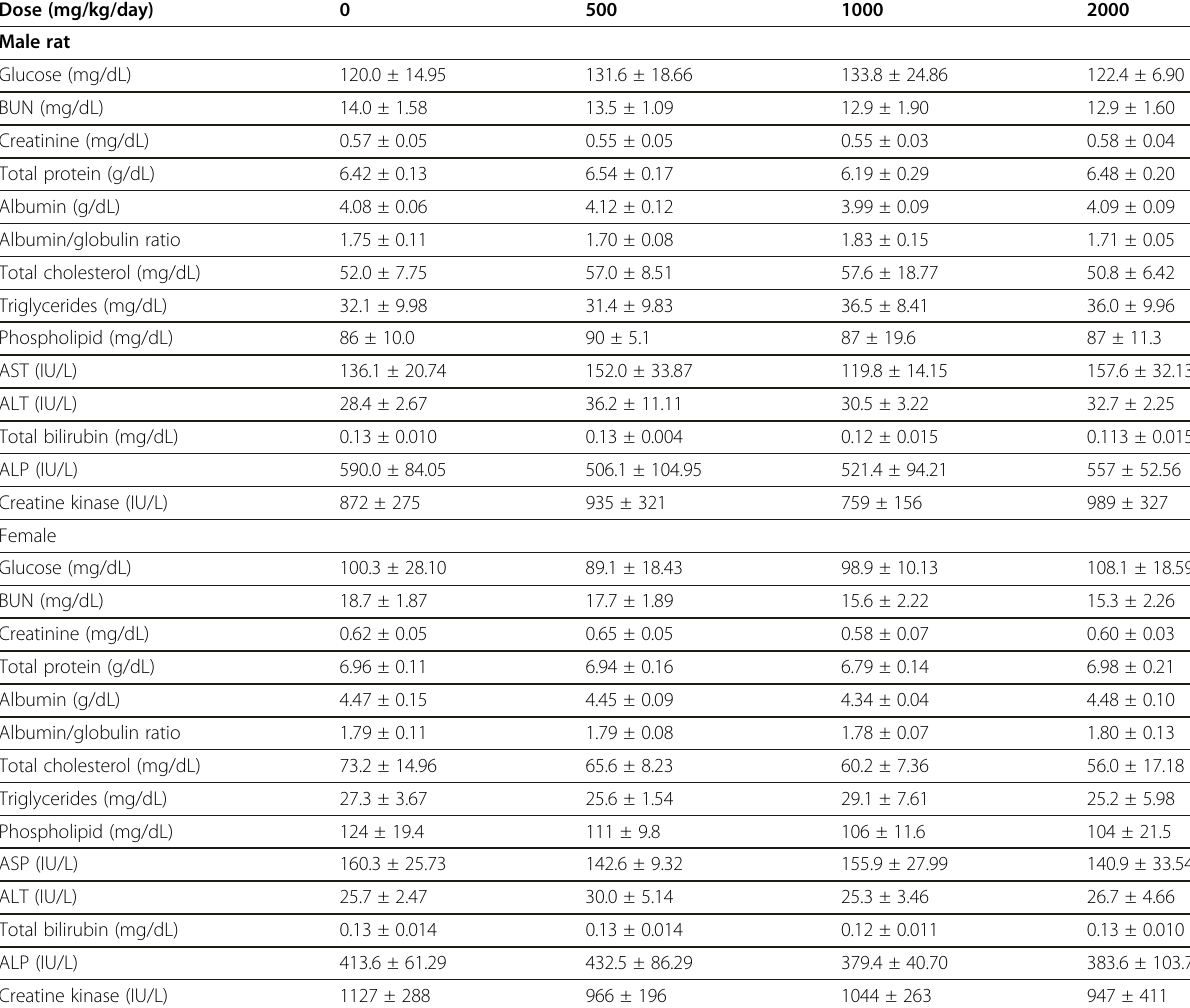
Table 4 Serum biochemical values of animals treated with SST for 4 weeks Dose (mg/kg/day)